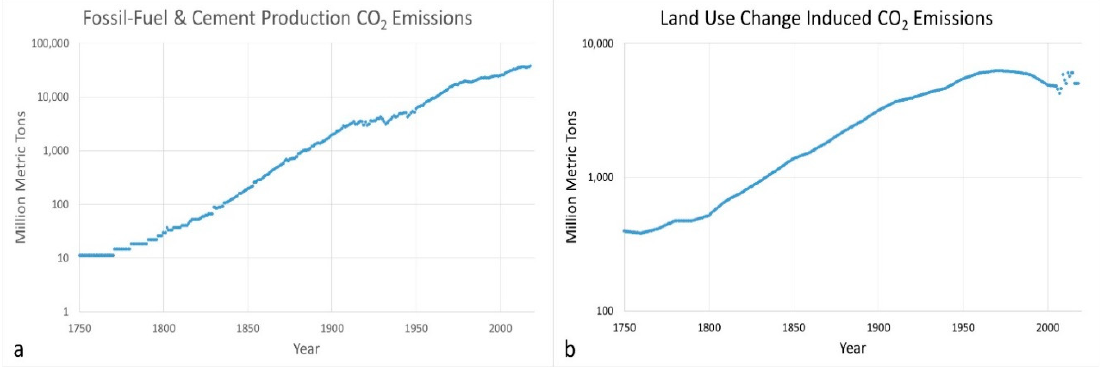
Figure 1. ( a ) Global CO 2 emissions into the environment from fossil fuel consumption and cement production [7,8], ( b ) global CO 2 emissions from land-use changes [9,10].